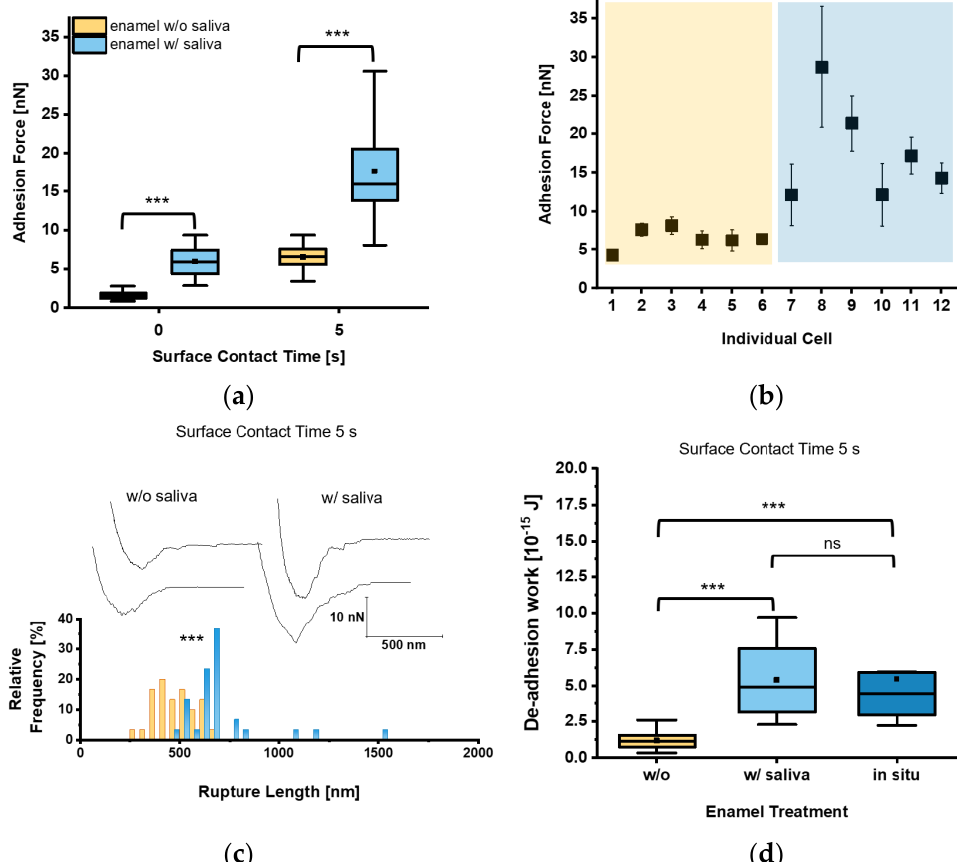
Figure 4. Adhesion of saliva-treated Candida albicans yeast cells to tooth enamel. ( a ) Adhesion forces of saliva-treated C. albicans yeast cells to untreated or saliva-treated enamel and for surface contact time delays of 0 s and 5 s. Data are presented in box and whisker plots (min-to-max), with median (horizontal line) and mean value (closed square). For each box 30 data points of six individual cells with five data points per cells are depicted. ***, p < 0.001 (Mann-Whitney U Test). ( b ) Adhesion forces of individual yeast cells. Shaded areas indicate treatment of the enamel w/o (orange) or w/(blue) saliva. Mean adhesion forces and standard deviations are indicated. ( c ) Representative retraction curves for untreated (left) and saliva-treated (right) enamel and rupture lengths for a surface contact time delay of 5 s are shown. The histogram for rupture lengths consists of a bin size equivalent to 50 nm. ***, p < 0.001 (Mann-Whitney U Test). ( d ) De-adhesion work of yeast cells for a surface contact time delay of 5 s for the untreated, saliva-treated, and in situ-exposed tooth enamel. Data from five to six individual cells with five data points per cell are presented in box and whisker plots (min-to-max), with median (horizontal line) and average (closed square). ns, not significant; ***, p < 0.001 (Kruskal-Wallis test followed by post-hoc